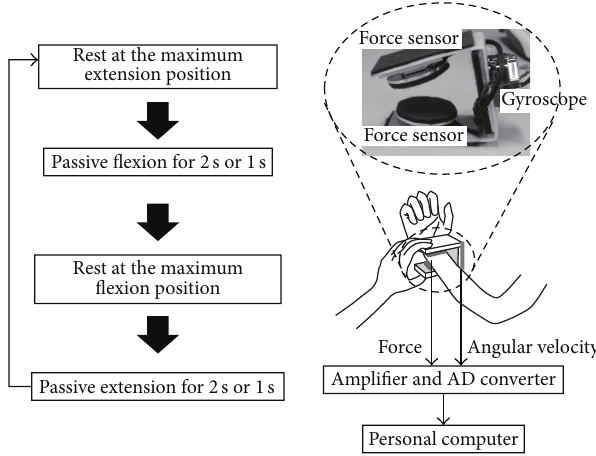
Figure 1: Overview of the muscle tone measurement system and the measurement